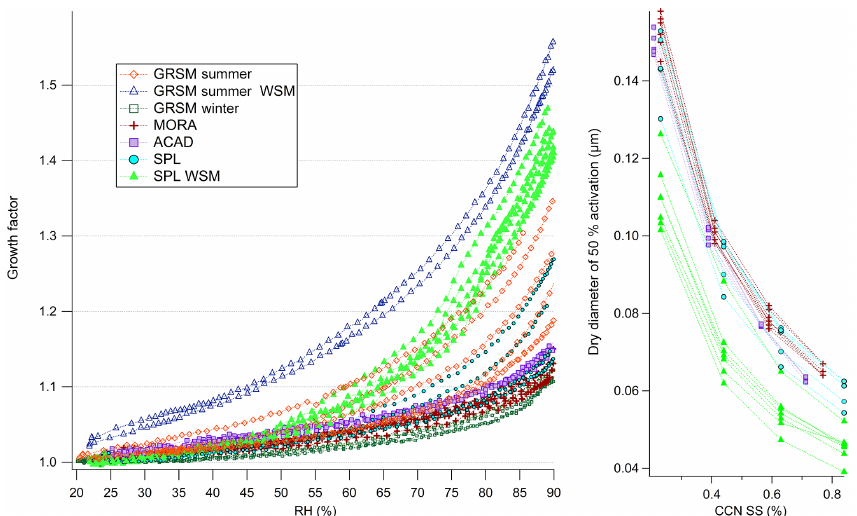
Figure 2. Hygroscopic growth curves for initially hydrated aerosol samples (designed to detect efflorescence) and CCN activity results. Hygroscopic growth was measured for all samples. CCN measurements were conducted only on MORA, ACAD, and SPL samples (both WSM and